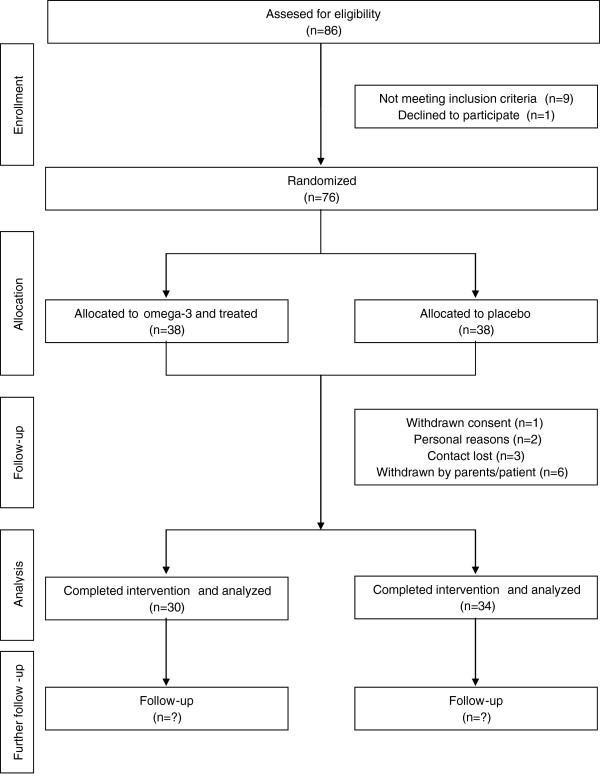
Patient CONSORT flowchart.